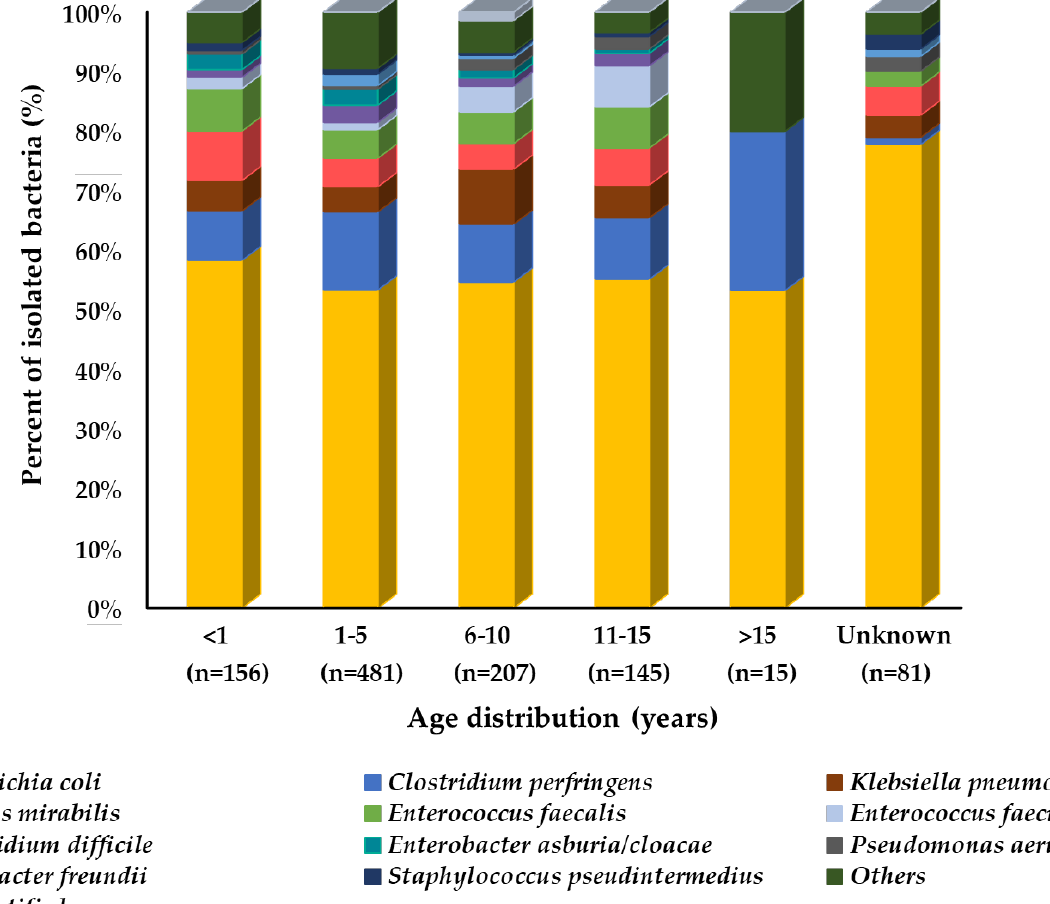
Figure 2. Prevalence of isolated bacteria (%) from dogs ’ diarrheal stool by age group (n = 1085). In the graph, “ n ” represents the number of recovered isolates.